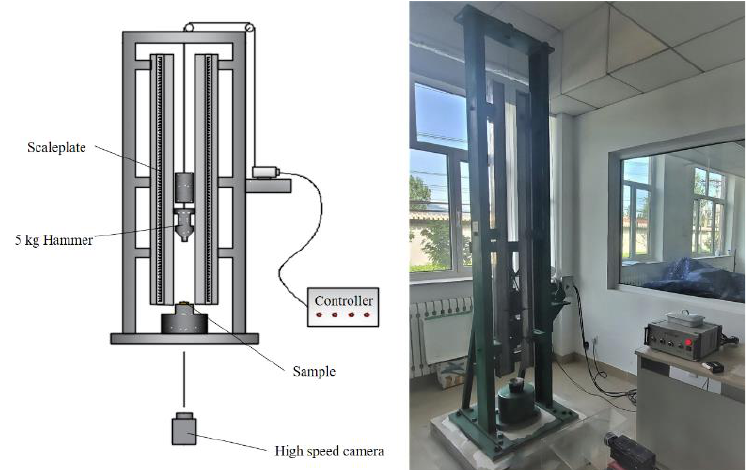
Figure 2. Schematic diagram of drop-weight test and site layout.